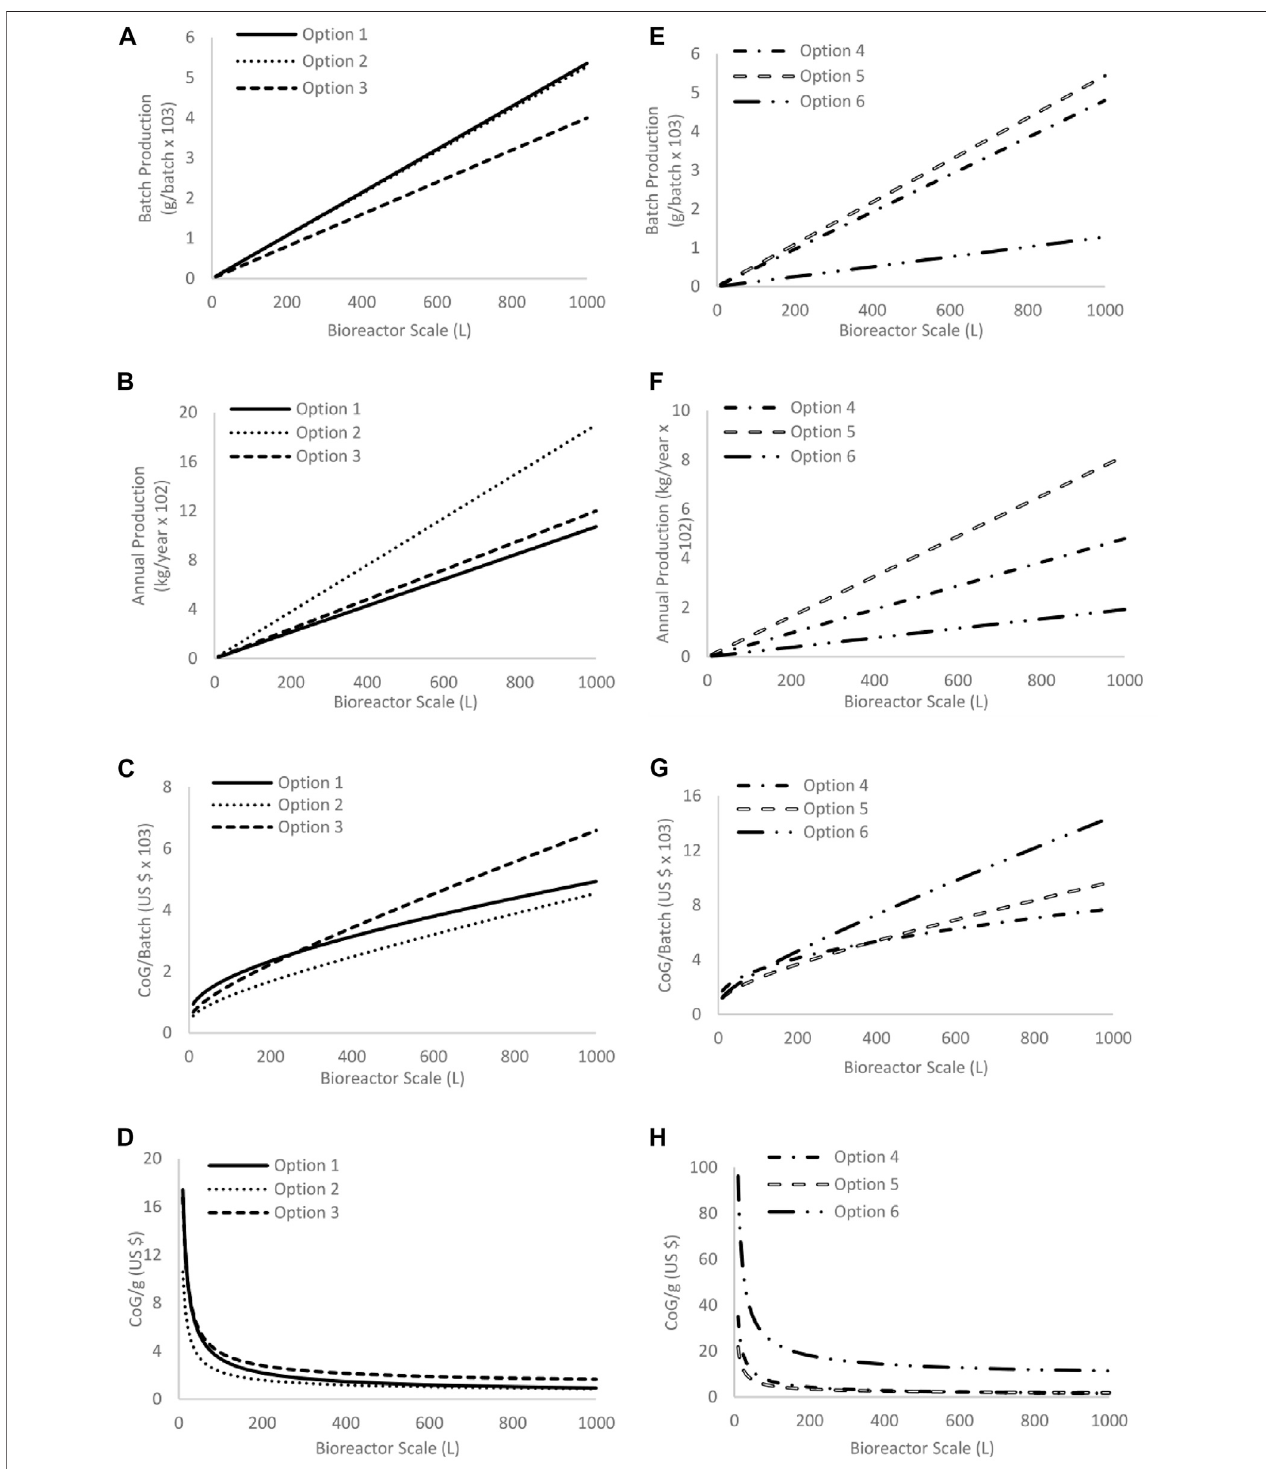
FIGURE 1 | Results contrasting fermentation options for endogenous and recombinant production. Speci fi c conditions of each option (1 – 6) are presented in Table 1 . (A – D) show results for endogenous production and (E – H) for recombinant production. panel 1A,E present batch production in grams per batch, panel 1B,F results for annual production (kg per year), (C,G) the cost of production per batch (US $ x103), and Figures 1D,H results for CoG/g (US $). All results were calculated for the bioreactor scales from 1 to 1,000 L in steps of 1 L.